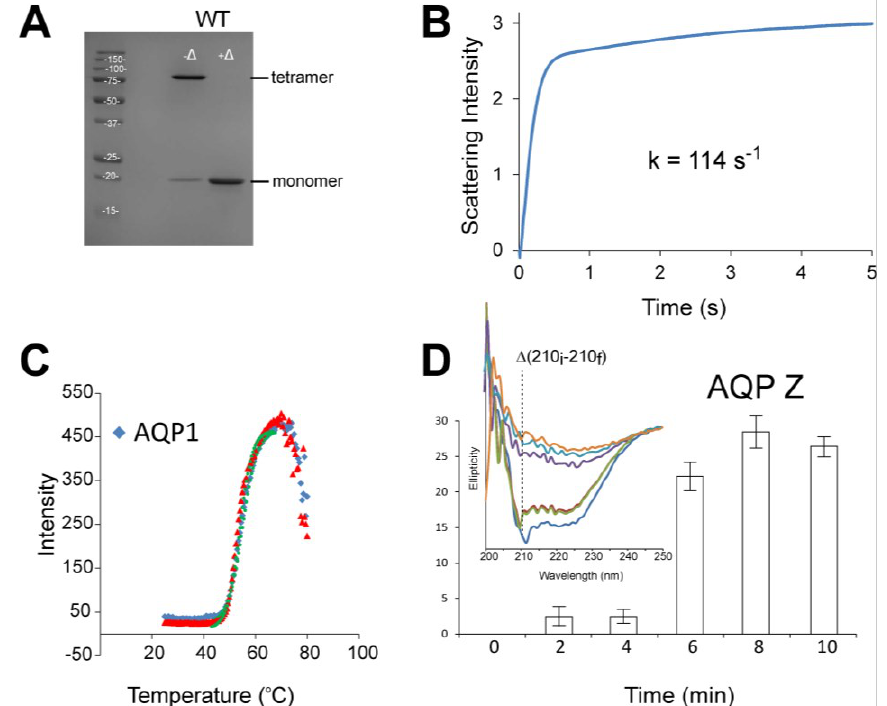
Figure 4. Aquaporin thermostability and functional assays. ( A ) In SDS, AqpZ is tetrameric at room temperature −Δ but monomeric at higher temperature +Δ; ( B ) Stopped-flow water permeability assay, where light scattering is continuously recorded after mixing AqpZ proteoliposomes with a high sucrose solution; ( C ) TSAdata of hAQP1 for two sample repeats (blue and red) obtained using StarGazer-384. Data collected can be analysed using the Bioactive software (Harbinger Biotech), where the measured scattering intensities are plotted as a function of temperature and fitted to the Boltzmann equation by non-linear regression (green line). The temperature of aggregation (T agg ) is defined as the point of inflection (dotted lines)Shift of T agg to a higher temperature indicates an increase in protein thermostability; ( D ) Unfolding of AqpZ, measured as decrease in ellipticity, when the protein is heated at constant temperature, e.g., 78 °C. In this case, the loss of α-helix content is measured at 210 nm, and expressed as the difference between the initial ellipticity at time zero (210 i ) and the ellipticity after a given time (210 f